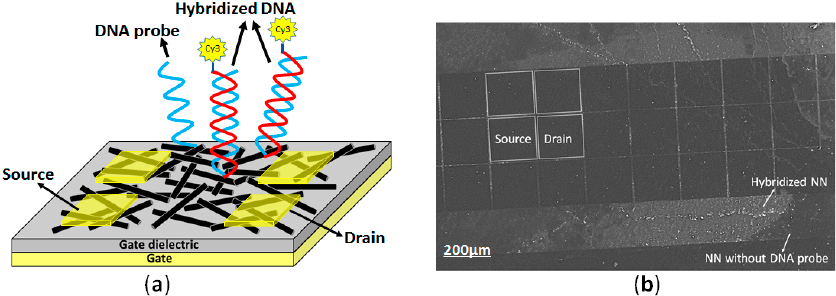
Figure 3. ( a ) SiNN FET with single and double strand DNA; ( b ) Fluorescent image of hybridized SiNN